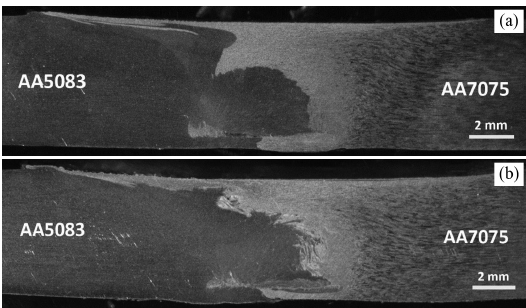
Figure 4. Macrographs of FSWed specimens: (a) Al (b) Al O -included. 2 3